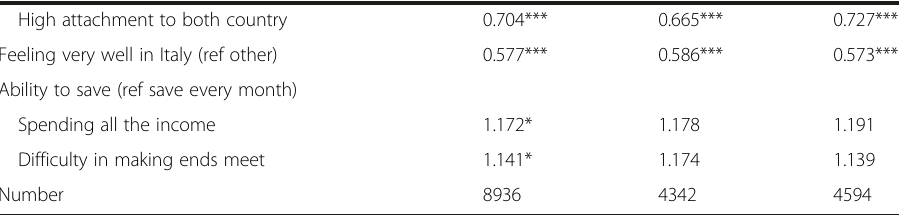
Table 2 Odds ratios and significance from the logistic regression models dependent variable plan for the future (baseline ‘ migrants with future plan ’ ) (Continued) High attachment to both